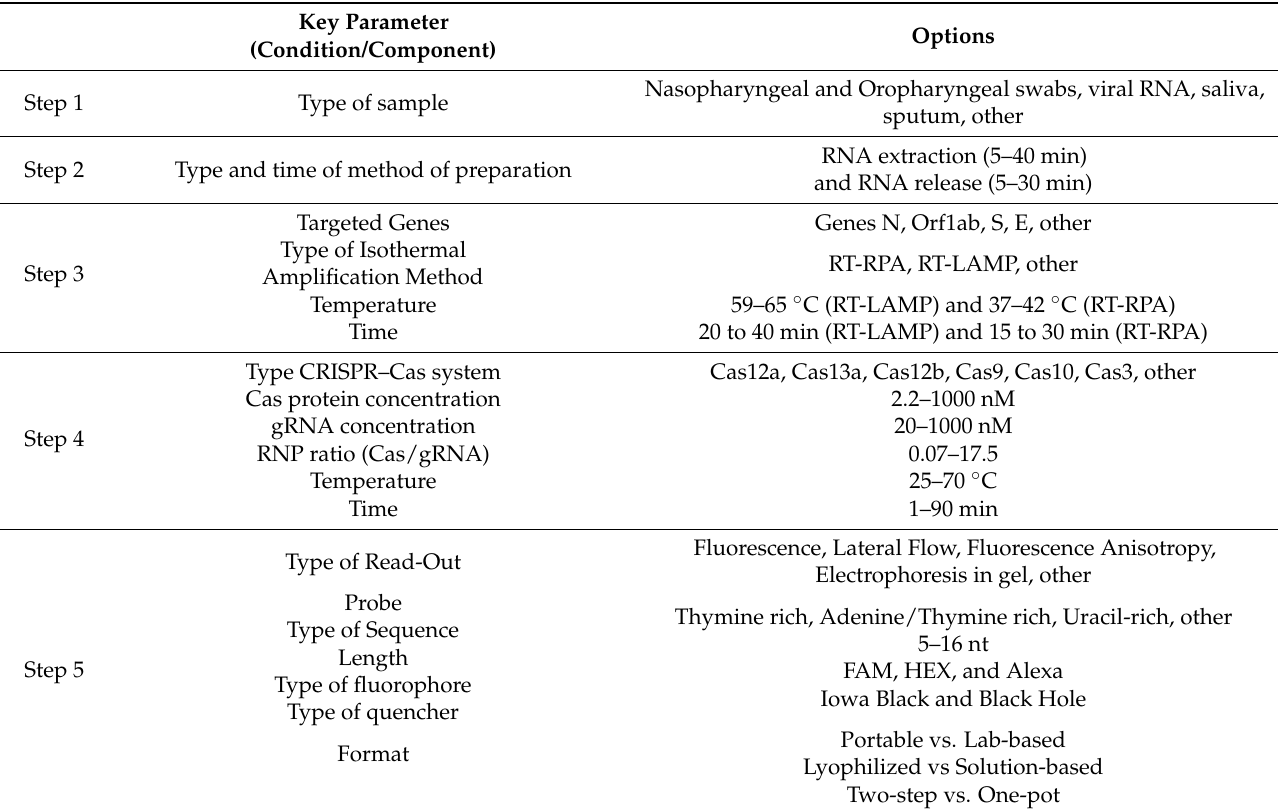
Table 1. Key parameters and their variability across the CRISPR-based methods to detect